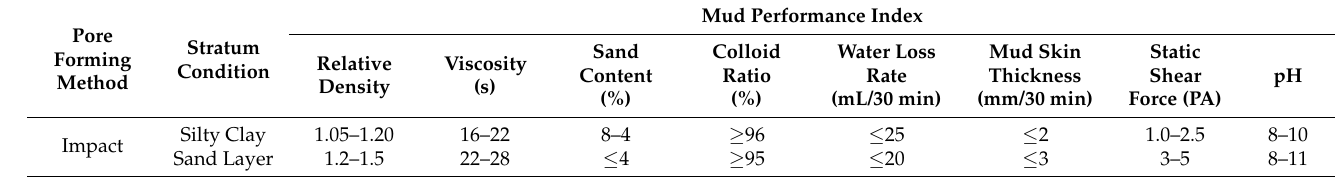
Table 1. Slurry performance